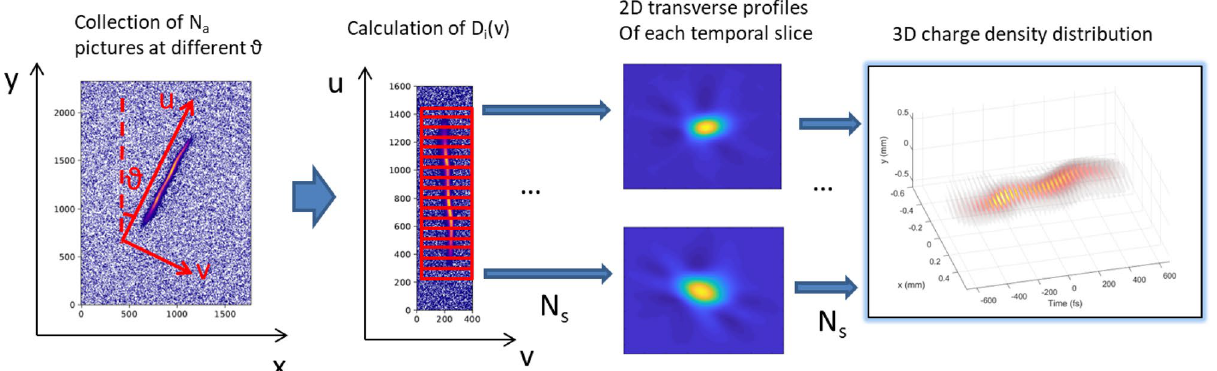
Figure 9. Algorithm for the tomographic reconstruction. The scheme illustrates schematically the conceptual steps performed in the data analysis of the images of the streaked beam to obtain a 3D reconstruction of the charge density distribution of the